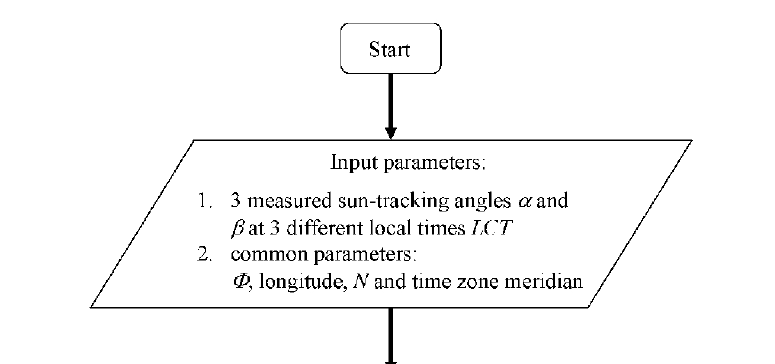
Figure 1. The flow chart of the computational program to determine the three unknown orientation angles that cannot be precisely measured by tools in practice, i.e., φ , λ and ζ